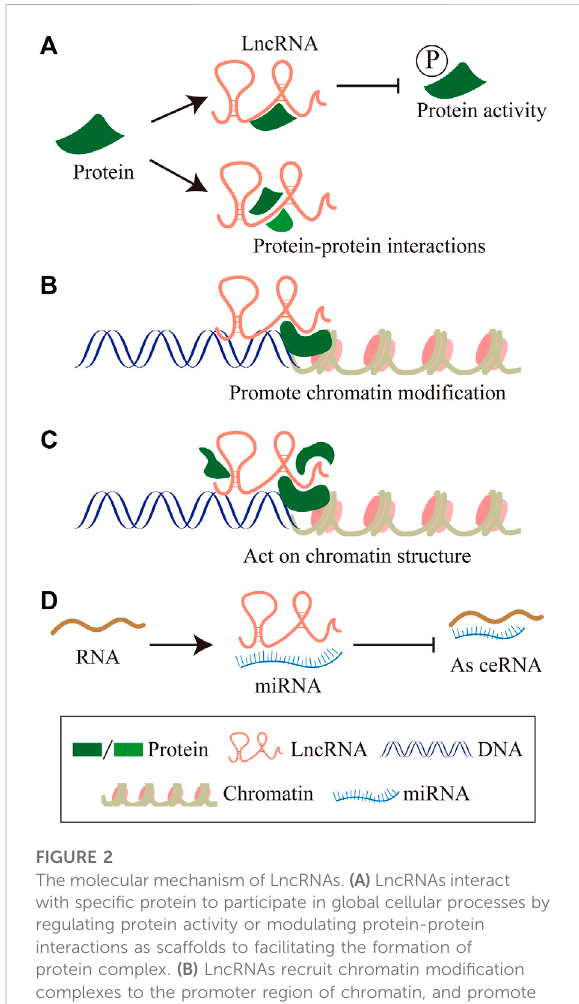
FIGURE 2 The molecular mechanism of LncRNAs. (A) LncRNAs interact with speci fi c protein to participate in global cellular processes by regulating protein activity or modulating protein-protein interactions as scaffolds to facilitating the formation of protein complex. (B) LncRNAs recruit chromatin modi fi cation complexes to the promoter region of chromatin, and promote chromatin modi fi cation. (C) LncRNAs recruit the DNA of RNA binding proteins (RBPs), remodel chromatin structure, thus regulating the expression of target genes. (D) LncRNAs sequester miRNAs from target mRNAs as competitive endogenous RNA.